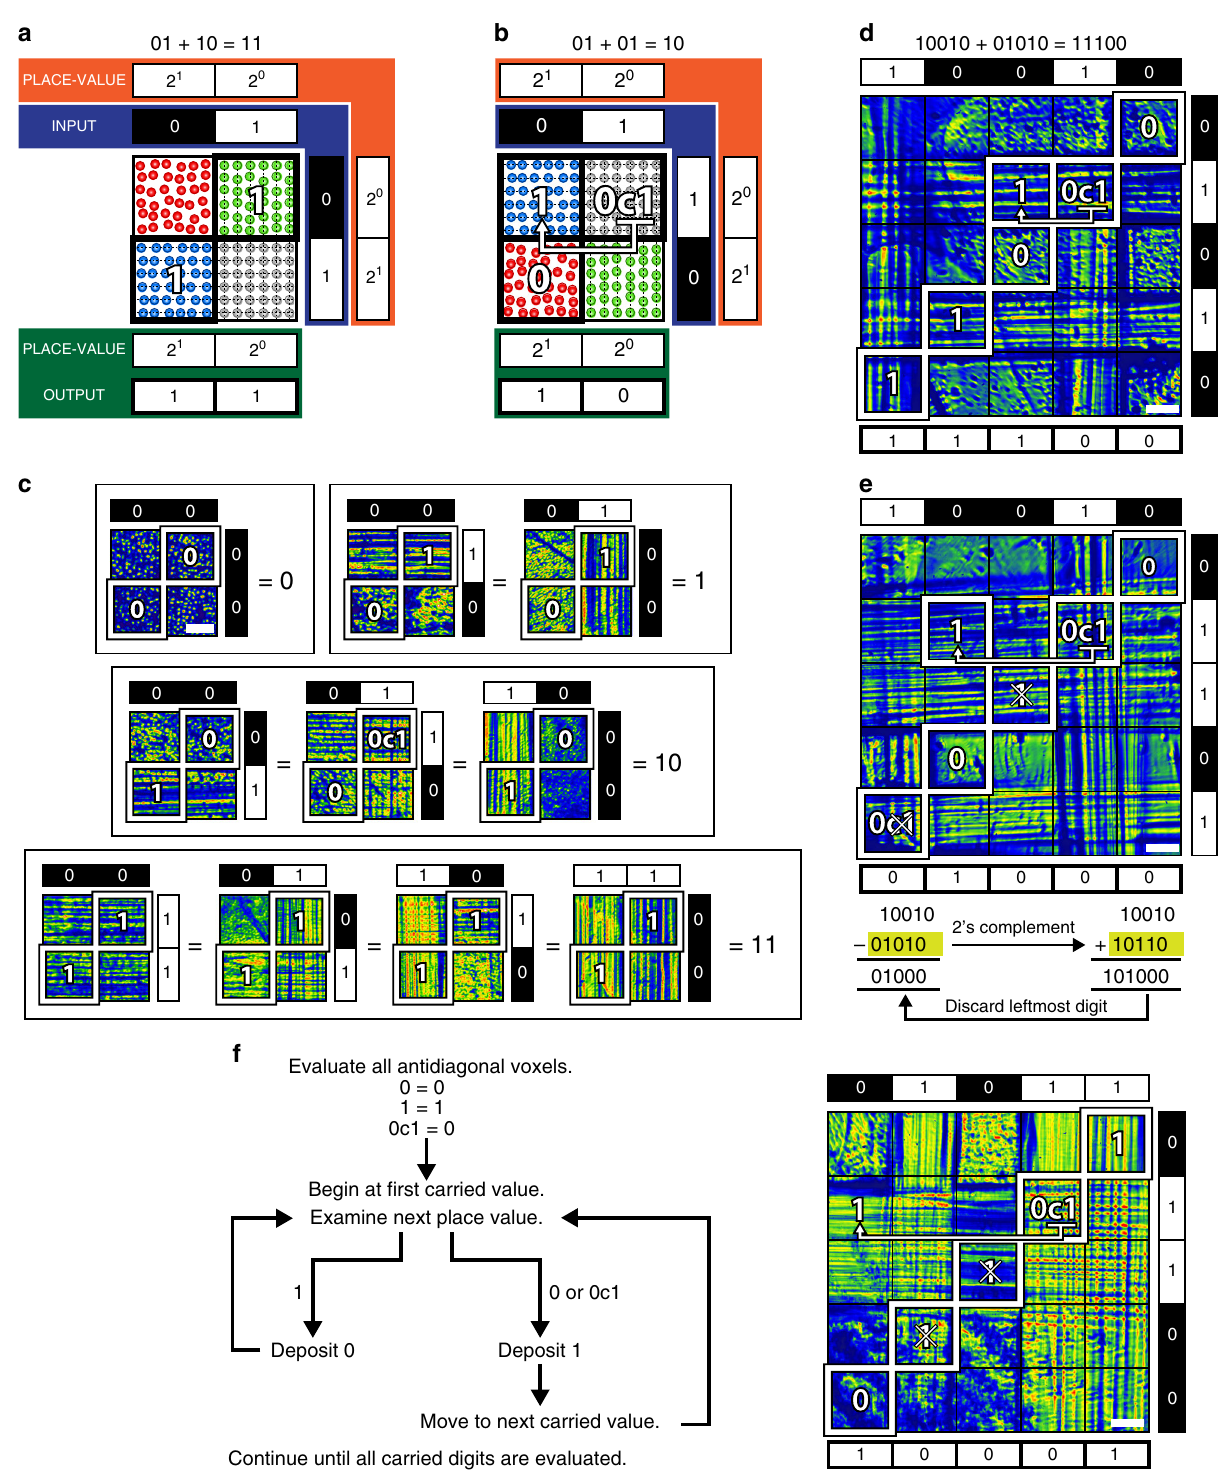
Fig. 5 Binary arithmetic. Schemes of addition of a 01 + 10 and b 01 + 01. Addends are input as binary strings through Beams Y and Z; place values are indicated. The result is contained in the antidiagonal of the output ( yz plane). Carrier con fi gurations 0D (red spots) = 0, 1DV (green spots), 1DH (blue spots) = 1, 2D (gray spots) = 0C1. c Addition is commutative and different addend pairs generate different output patterns but the same sum; examples from the 2 2 × 2 2 system are tabulated. Any addend may be added on the grid, provided that the sum does not exceed N digits for a 2 N × 2 N grid. Shorter binary strings are accommodated by appending leading zeroes as shown in d for the sum of 10010 and 1010 performed on a 2 5 × 2 5 system. Subtraction is accomplished by adding the two ’ s complement of the minuend. We determine e the difference between 10010 and 1010 by adding 10110 and dropping the leftmost digit. This occurs naturally as the bottom – left voxel signi fi es a carried digit that cannot be contained within the grid. f A fl owchart summarizing the steps of an addition algorithm including the treatment of carried over digits as exempli fi ed in the accompanying output pattern corresponding to the sum of 01011 and 00110. ( c – f scale bar = 500 μ